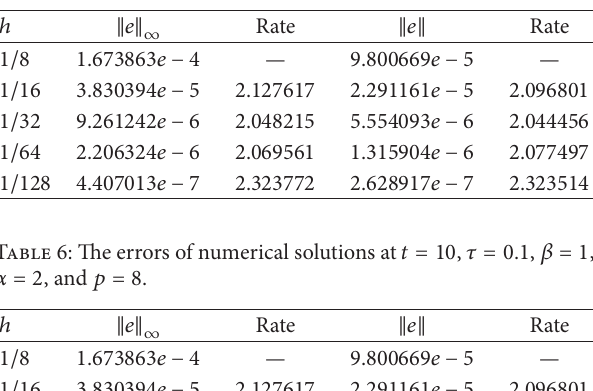
Table 5: The errors of numerical solutions at 𝑡 = 10 , 𝜏 = 0.1 , 𝛽 = 1 , 𝛼 = 2 , and 𝑝 = 4 .